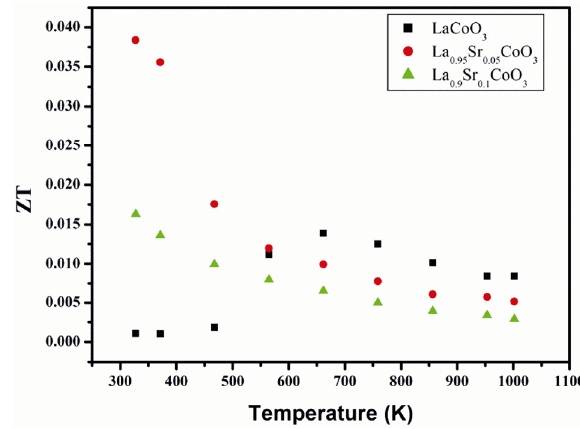
Fig. 12 Temperature dependence of the ZT value of the La 1– x Sr x CoO 3 sample with x = 0, 0.05, and